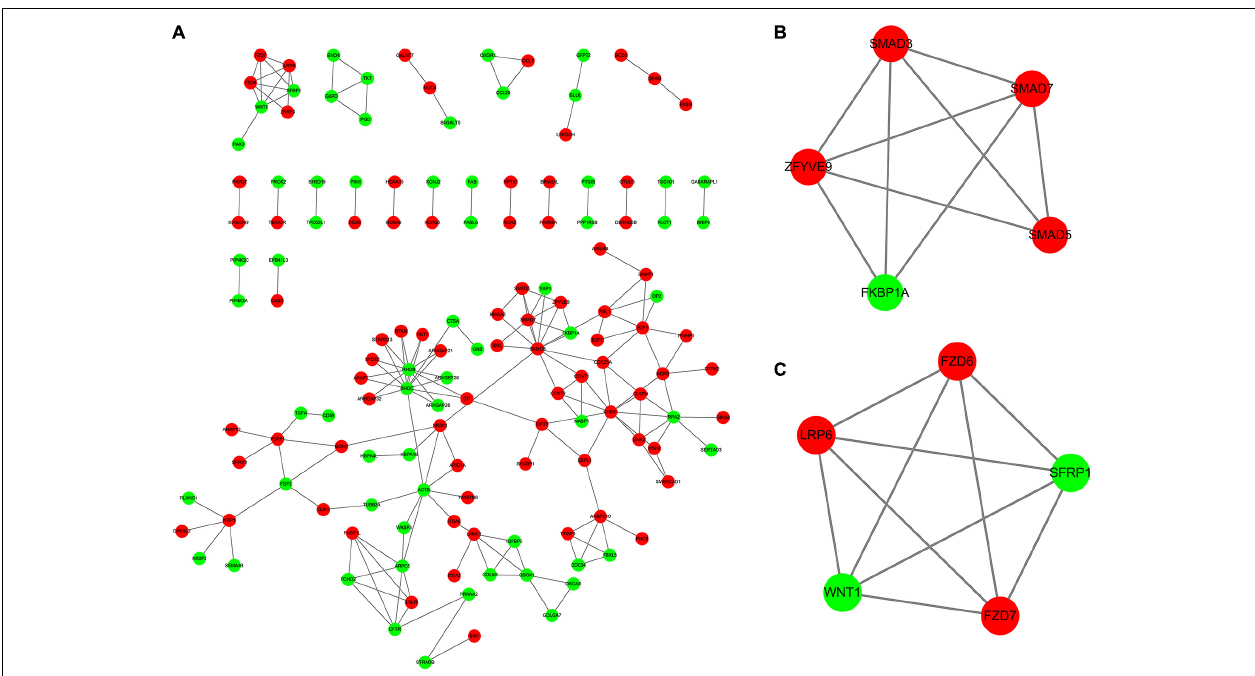
FIGURE 8 | Identification of hub genes in the PPI network. (A) Construction of PPI network based on the DEmRNAs in the ceRNA network. (B,C) Two PPI subnetworks for ALL. Red represents upregulation and green represents downregulation. DEmRNAs: Differentially expressed mRNAs.